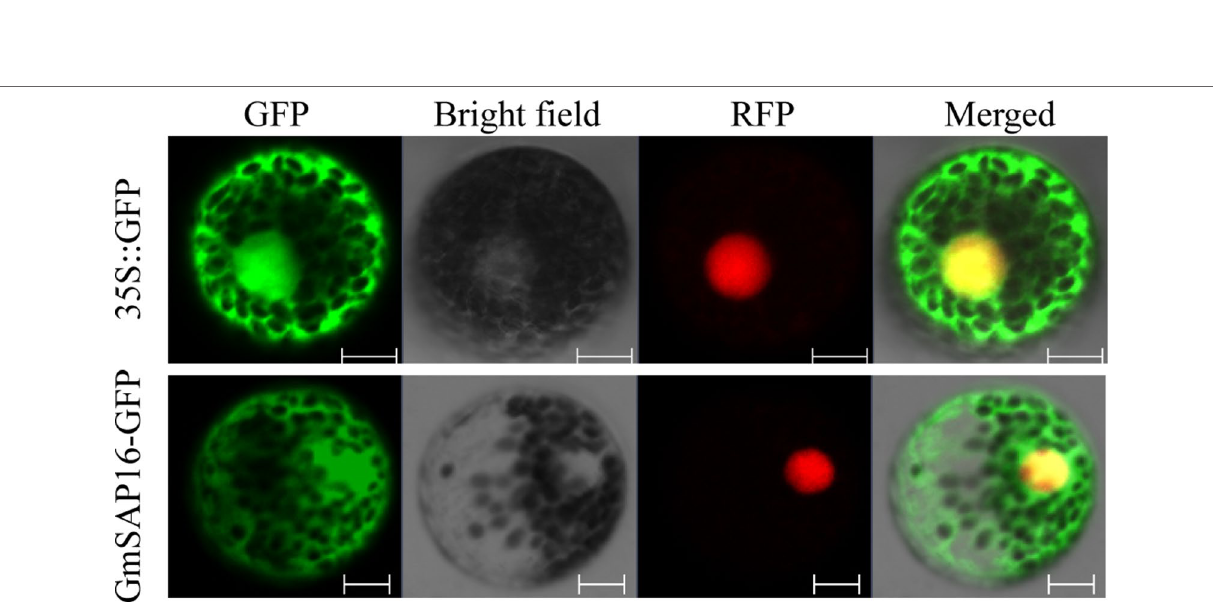
Frontiers in Plant Science |